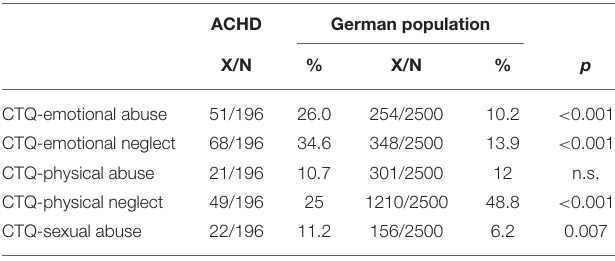
TABLE 2 | Prevalence of child maltreatment in adults with congenital heart disease: comparison to data from the German population (25). ACHD German population X/N % X/N % CTQ-emotional abuse CTQ-emotional